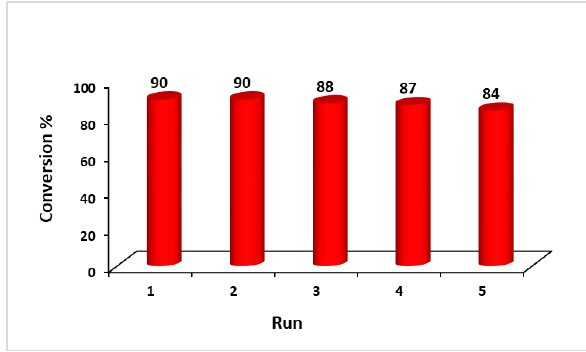
Figure 9. Reusability of the Mn-supported nano-catalyst.